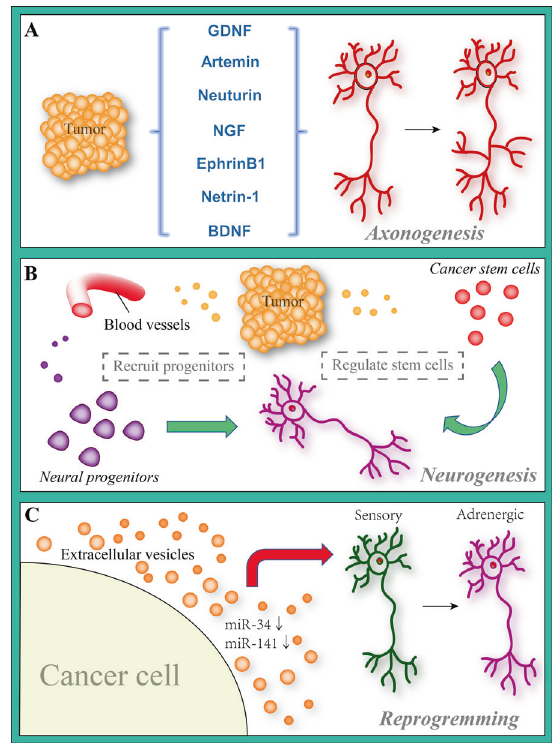
Fig. 1 Tumor-mediated nerve neurogenesis, axonogenesis and reprogramming in the TME. A During tumor progression, neuro- genic factors, such as GDNF, BDNF, NGF, Artemin, Neuturin, EphrinB1, and Netrin-1, are released by tumor cells, inducing the axonal growth of nerves. Neurotrophin binding to its cognate receptors on nerves affects axonogenesis. B Tumor cells can recruit neural progenitors into the tumor stoma via the circulatory system, where they are stimulated by TME factors to differentiate into mature nerves. In addition, nerves also can directly regulate cancer stem cells via multiple signals. C Prior research has suggested that cancer-related extracellular vesicles play an important role in this reprogramming